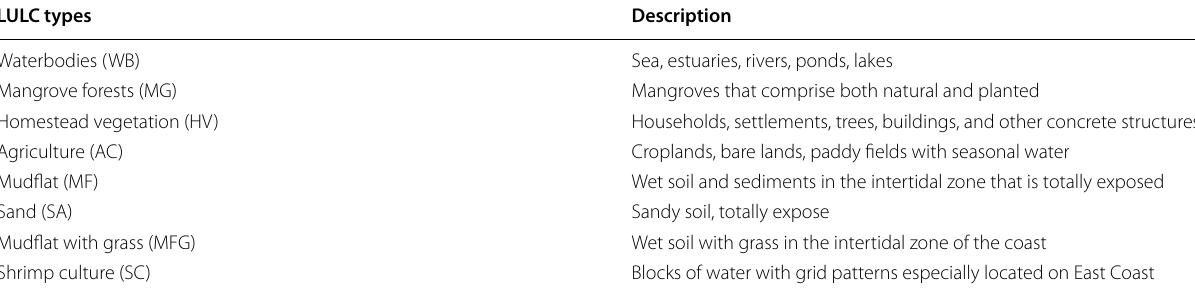
Table 3 The classification scheme for land use and land cover for the study